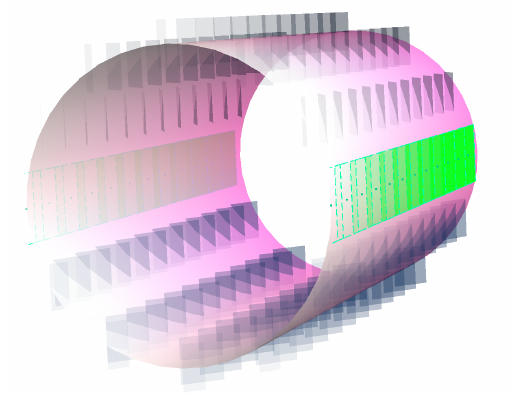
Fig. 6. Intersection of the contact distribution in R 3 with the equation ( u ′ ) 2 + u 2 = 1 .